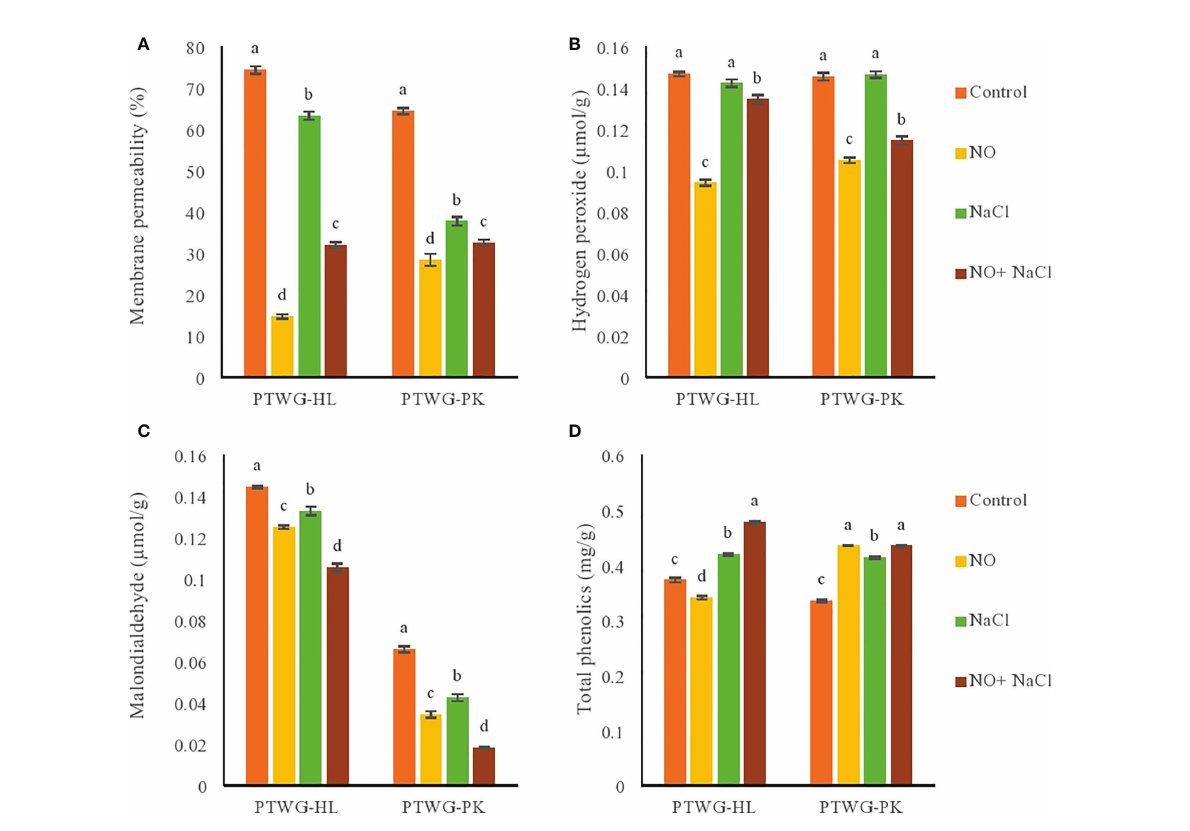
FIGURE 3 Shows membrane permeability, hydrogen peroxide, malondialdehyde and total phenolic content of forty-two days old ecotypes of turnip ( Brassica rapa L.) under sodium chloride and nitric oxide stress. (A) Membrane permeability, (B) Hydrogen peroxide, (C) Malondialdehyde, (D) Total phenolics. Means with the same letters on each bar do not differ signi fi cantly at the 5%